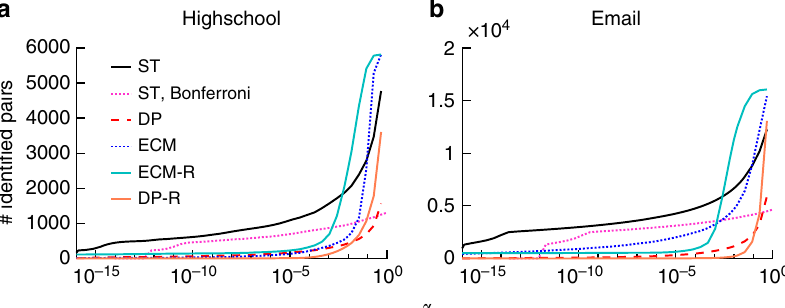
Fig. 3 Number of signi fi cant ties as a function of the signi fi cance level for the a Highschool and b Email data sets. The dotted pink line denotes the ST fi lter with Bonferroni correction, while black solid, red dashed, blue dotted, light-blue solid, and orange solid lines represent the ST, DP, ECM, ECM-R, and DP-R fi lters without Bonferroni correction, respectively. Temporal resolution is Δ = 15 min for Highschool and 1 day for Email NATURE COMMUNICATIONS| (2019) 10:220